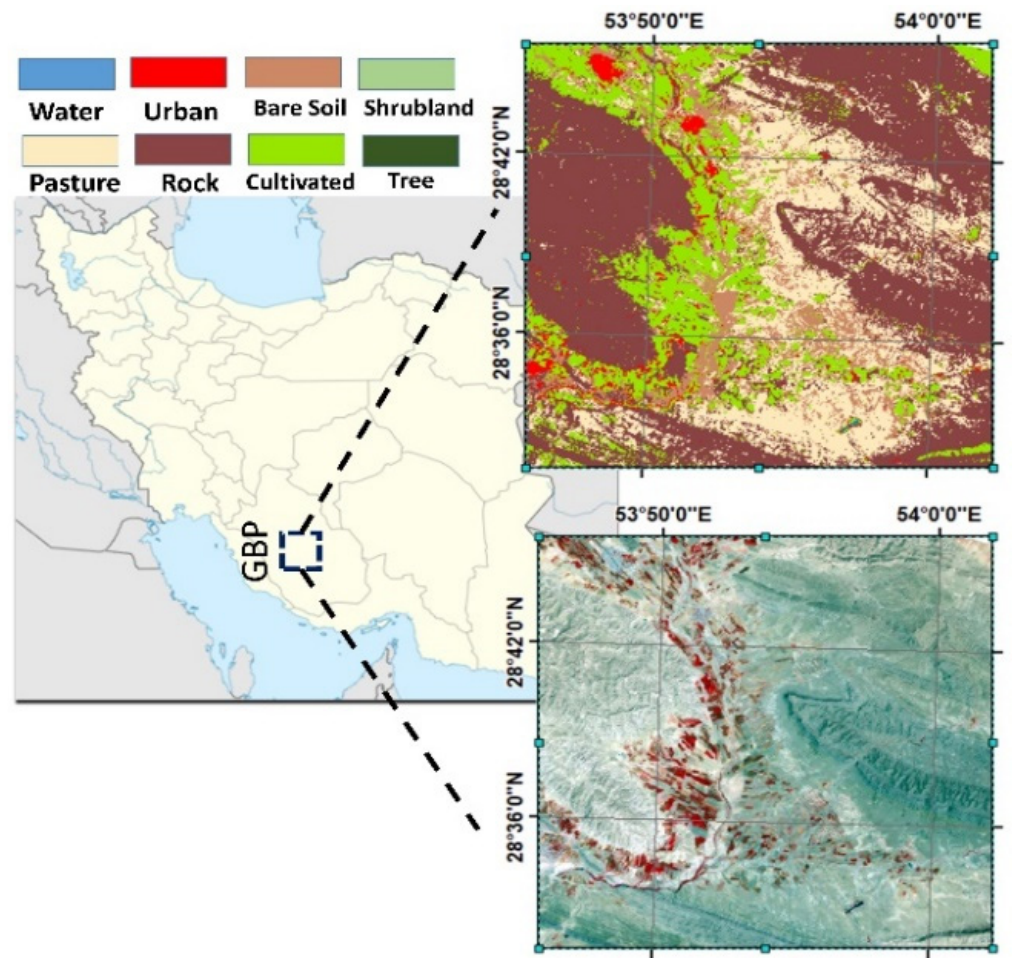
Figure 1. Location of the study region in Iran and a map of the main land use types. GBP refers to the Gareh Bygone Plains region.